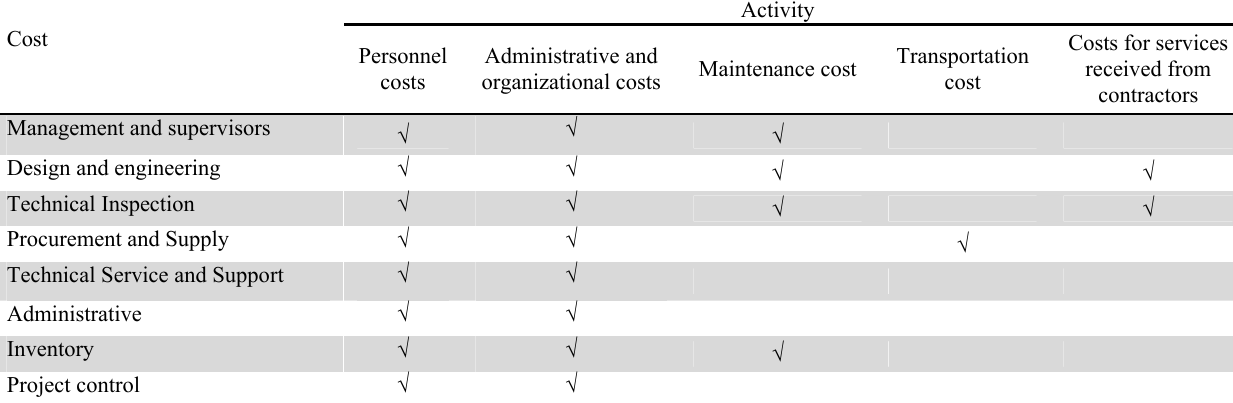
Expense-Activity-Dependence (EAD)